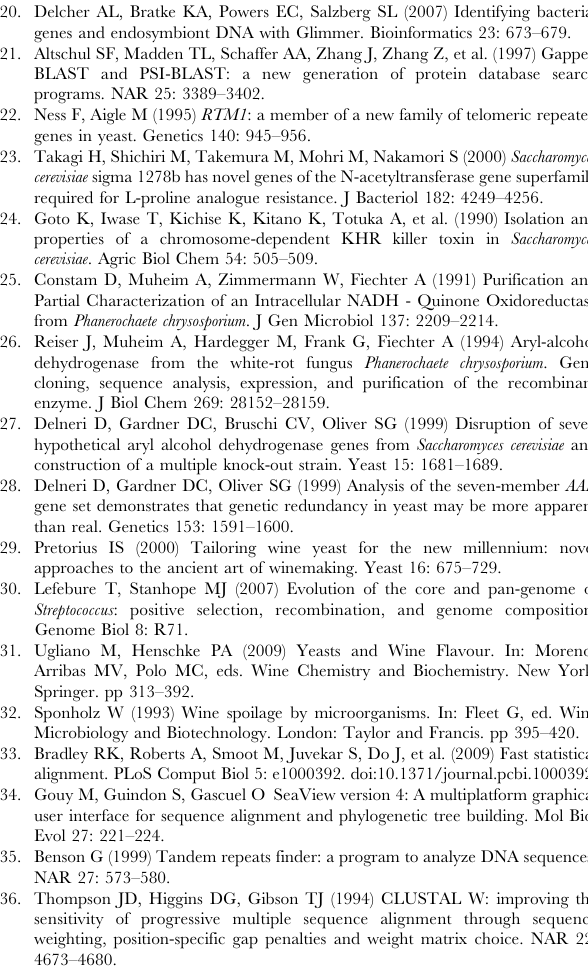
Figure S2 Clustal alignment of the five-gene cluster present in wine yeasts. Figure S3 A model for the horizontally-acquired five-gene cluster.